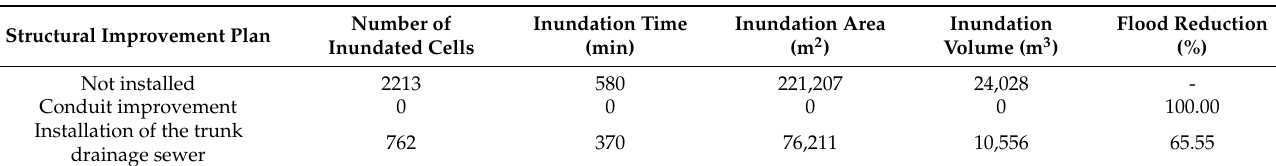
Table 8. Flood analysis in the Dowon watershed according to the flood damage reduction facility installation conditions.